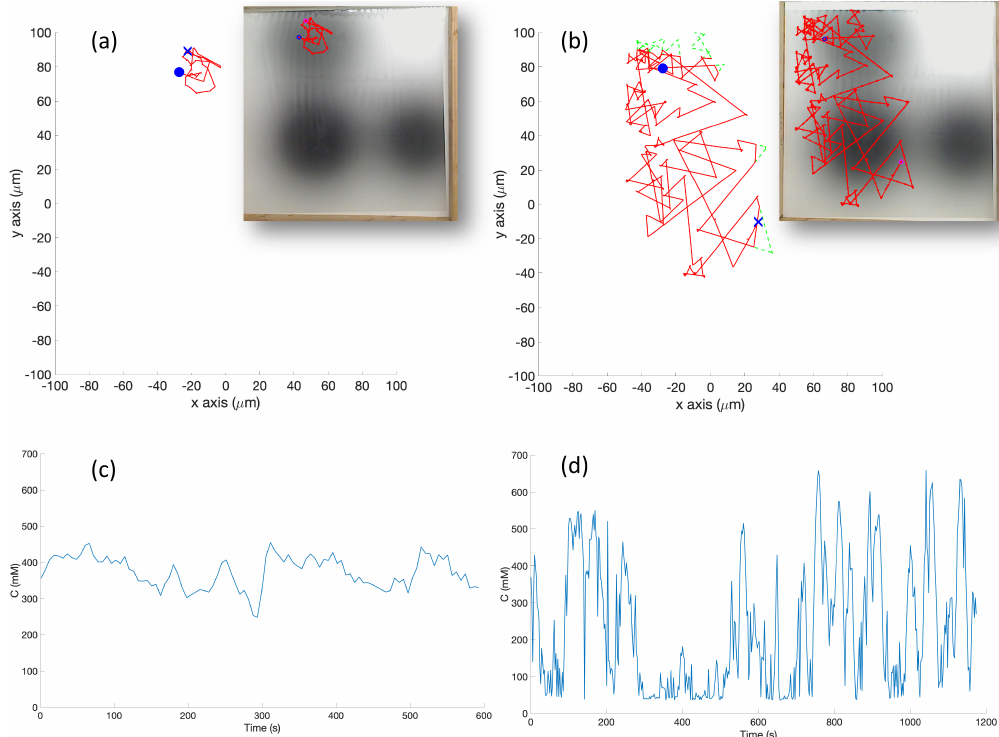
Figure 15. Case 6: Without obstacles, in the triple-effluent environment, typical trajectories of the e-puck robot running ( a ) the basic chemotaxis controller, and ( b ) the RapidCell chemotaxis controller. In each trajectory, the initial position is shown as a blue circle and the terminal position is shown as a blue “X”. Positions corresponding to concentrations less than 1m M are shown in dashed green, otherwise shown in red. The recorded concentrations associated with each scheme are shown in ( c , d )